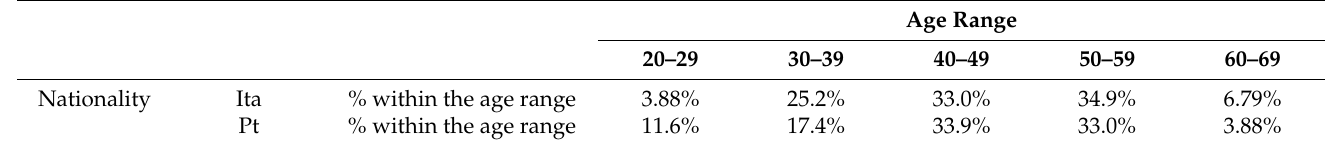
Table 2. Age range by nationality.